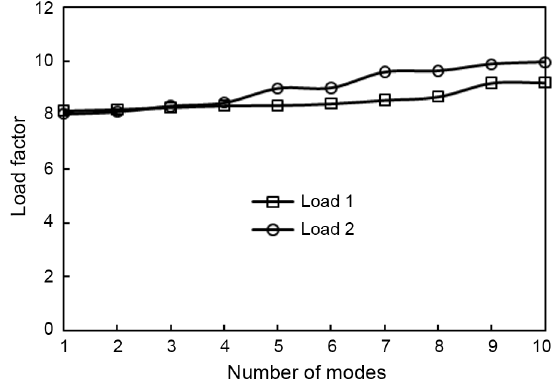
Fig. 6. Critical load factors of hybrid grid shells